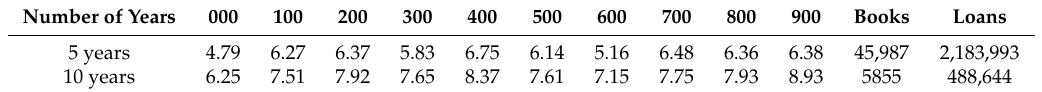
Table 8. Half-lives of books that were considered core collections for consecutive